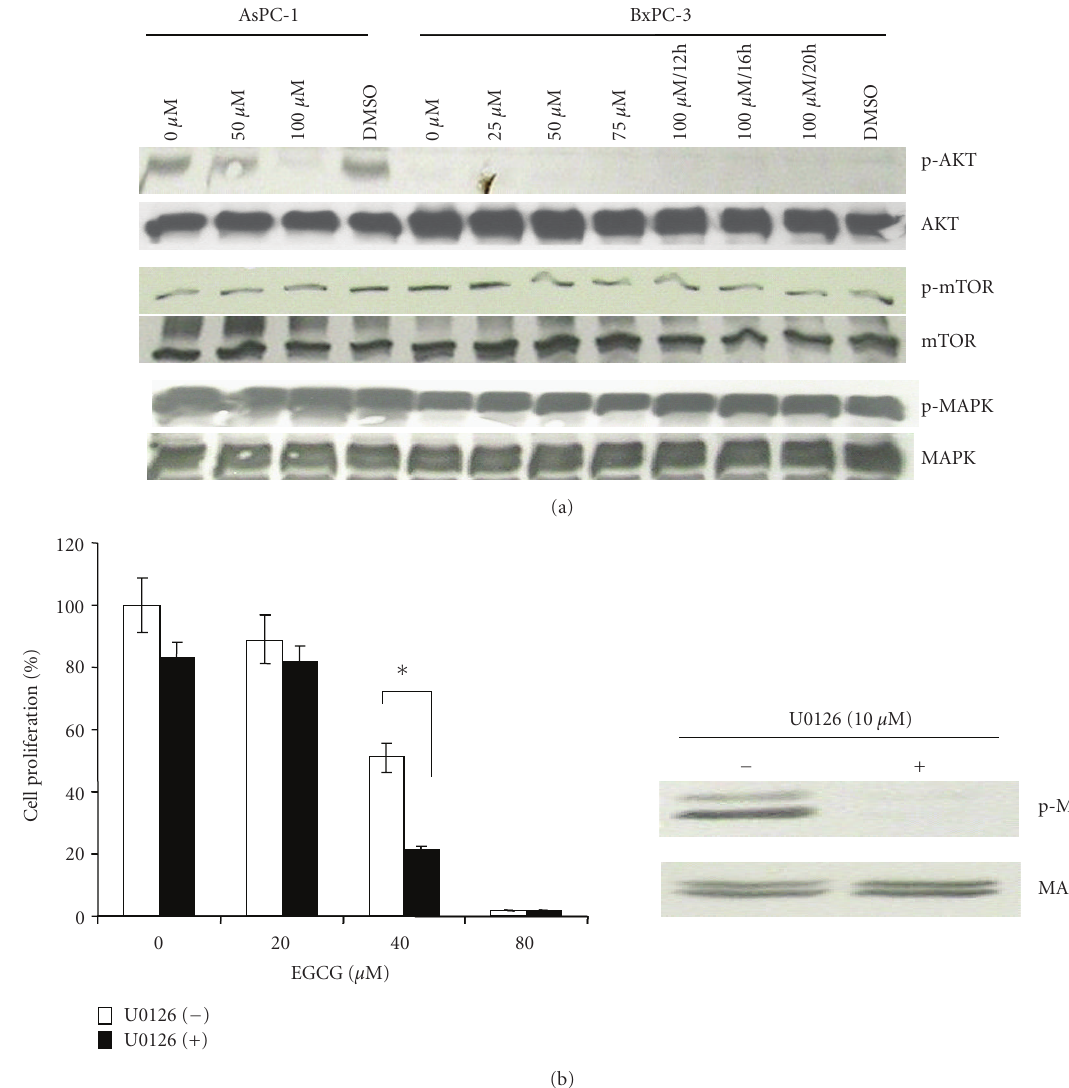
Figure 4: (A) EGCG fails to inhibit phosphorylation of MAPK and mTOR in AsPC-1 and BxPC-3 cells. Cells were plated at a density of 2 × 10 5 cells/ml in the presence of various concentrations of EGCG for 12 hours, except for BxPC-3 at 100 μ M for additional 4 or 8 hours. Total cell lysates were subjected to western blot analysis. (b) MAPK inhibitor enhances EGCG-induced antiproliferative response in BxPC-3 cells. Cells were plated at a density of 0.6 × 10 5 cells/ml in 24-well dishes with di ff erent concentrations of EGCG for 48 hours in the presence or absence of 10 μ M U0126 (MEK1/2 inhibitor). Cells were detached by trypsin, stained with trypan blue and counted manually using a hemacytometer. Values were obtained from experiments conducted in triplicate. Asterisk indicates significant di ff erence. Inhibition of phosphorylation of MAPK by U0126 at 10 μ M was confirmed with western blot